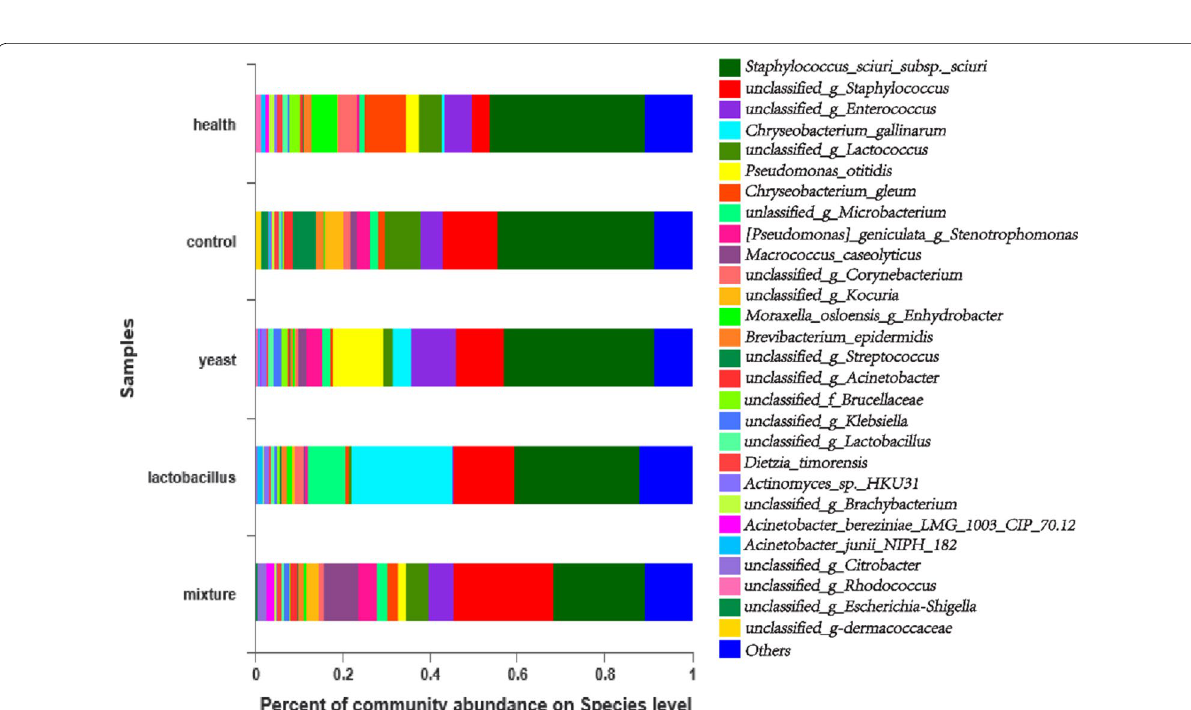
Fig. 5 The effect of treatments on the distribution of milk bacterial community at the species